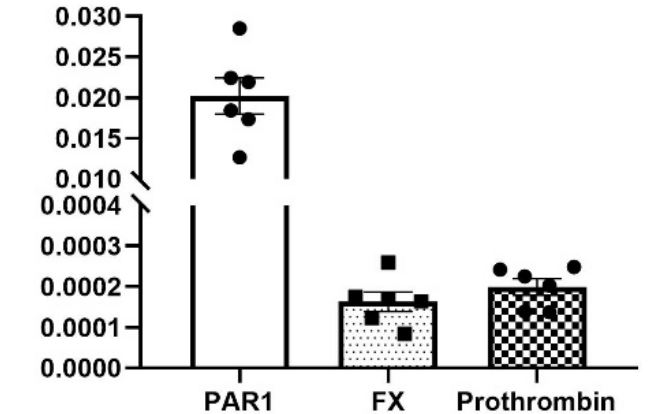
Figure 5. Expression of coagulation factors mRNA in mouse neuroretina. The mRNA expression levels of Factor X (FX), prothrombin and PAR1 in the neuroretina were determined by quantitative real ‐ time reverse transcriptase PCT (qRT ‐ PCR) analysis of neuroretinas derived from six mice (13 ‐ week ‐ old). Results are presented relative to hypoxanthine guanine phosphoribosyltransferase expression using the 2^ Δ CT calculating method.